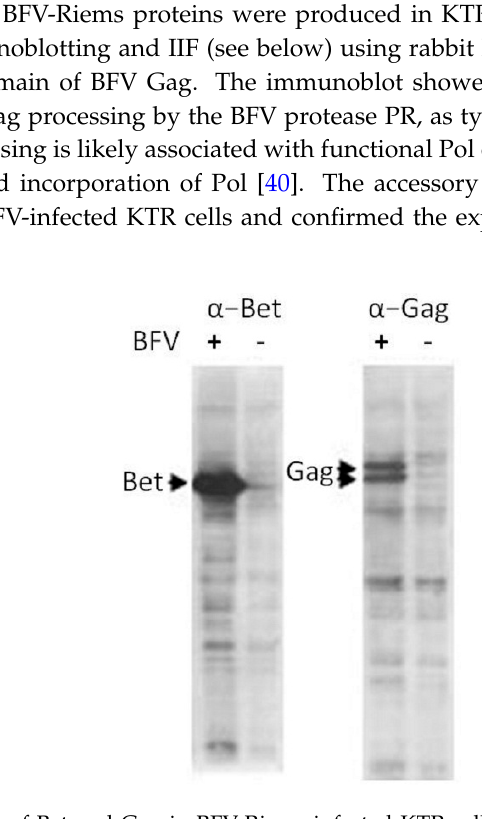
Figure 1. Expression of Bet and Gag in BFV-Riems-infected KTR cells. Cell lysates were harvested from BFV-Riems infected and uninfected KTR cultures for immunoblotting using BFV-Riems-specific antisera directed against BFV Bet and Gag MA. The positions of detected proteins are indicated by arrows.